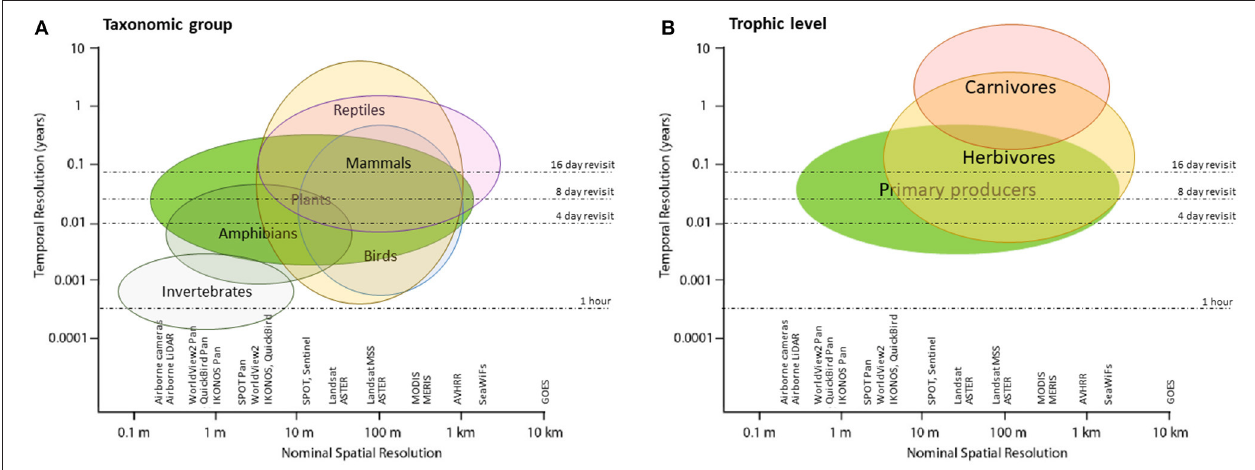
FIGURE 1 | Temporal and spatial resolution of most common remote sensing sensors, and their applicability for generating predictor variables for several biological